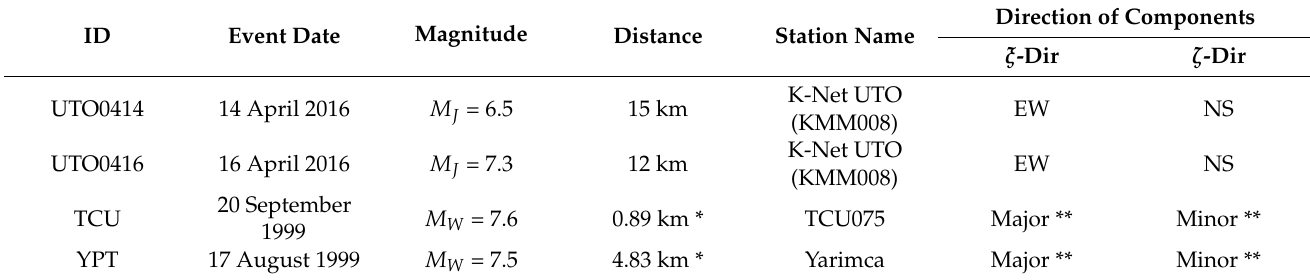
Table A1. Event date, magnitude, location of the epicenter, distance, and station name of each record.